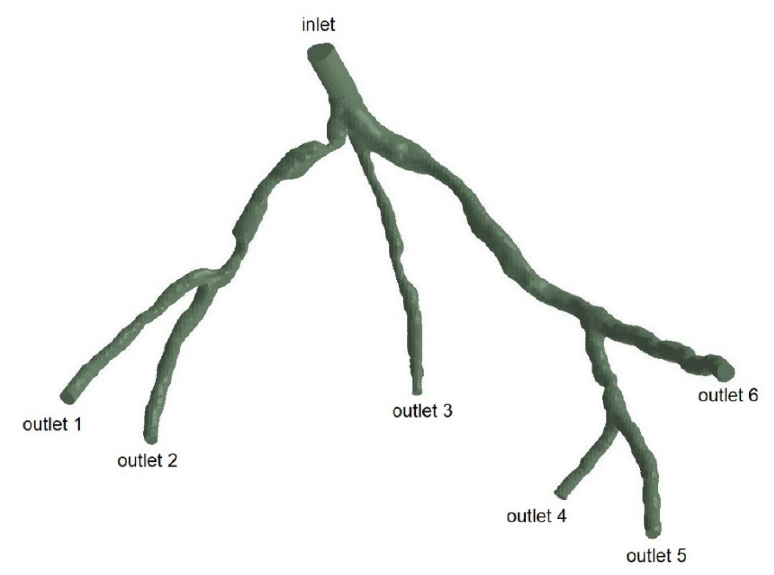
Figure 4. Geometry of inlet and outlets of the CHN13